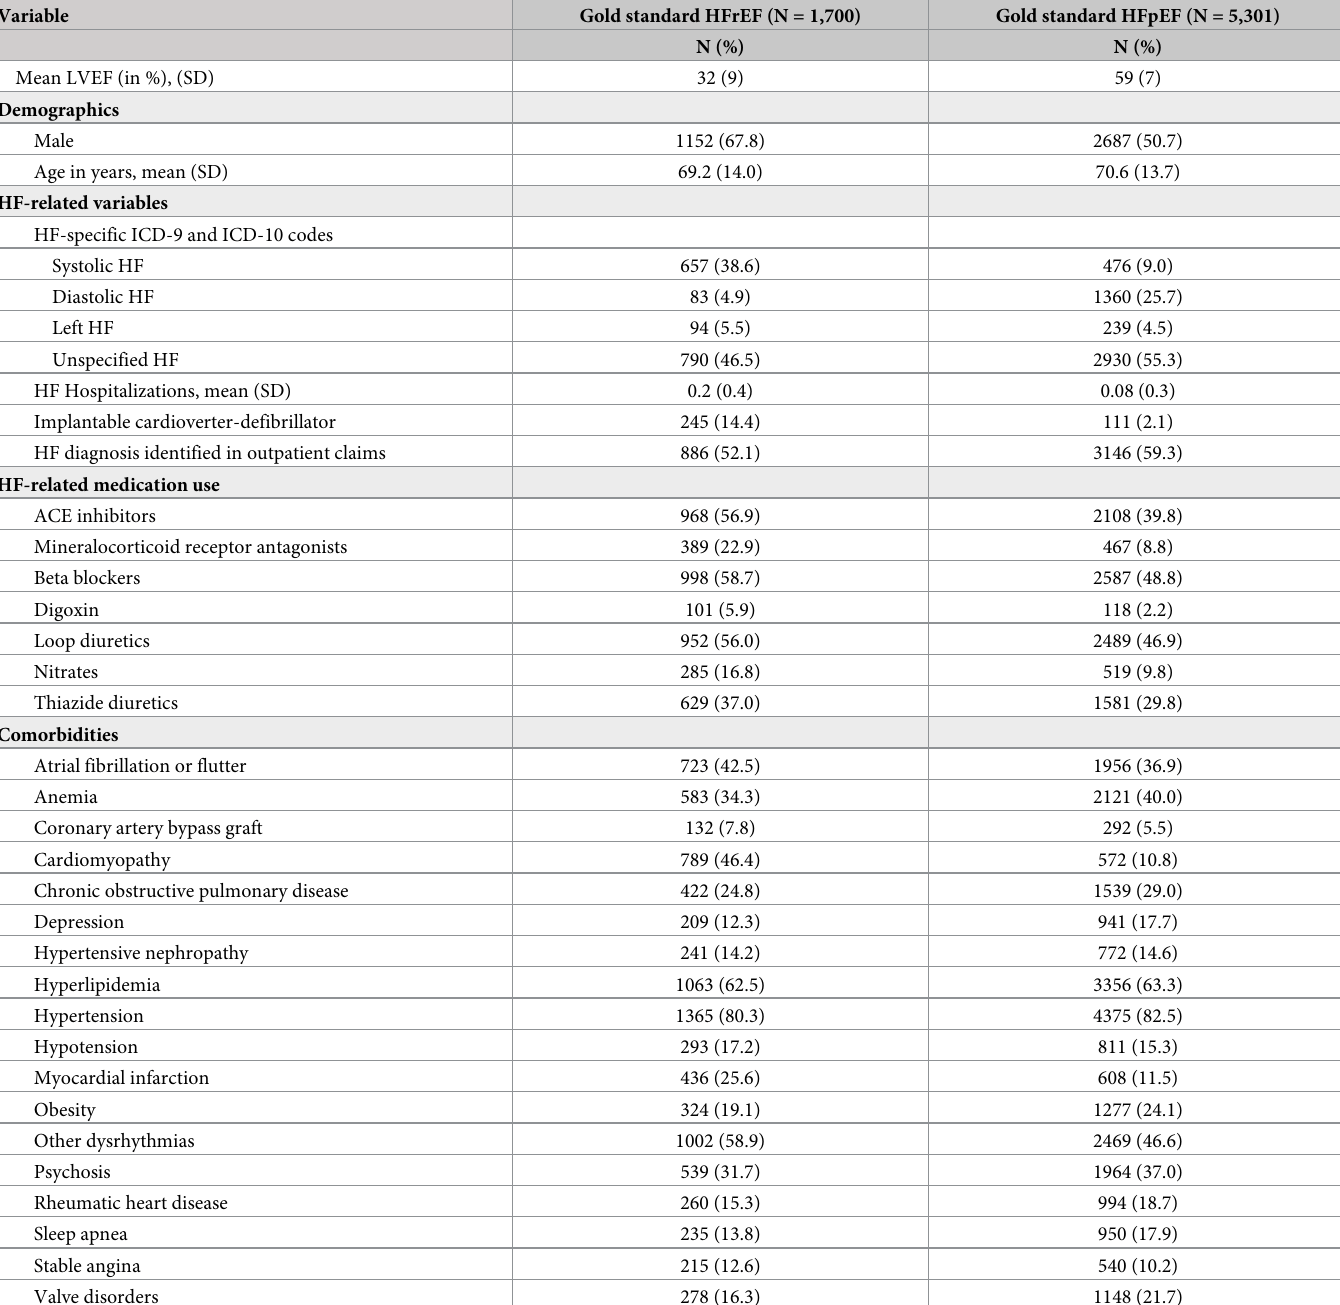
Table 1. Baseline characteristics of HF patients stratified by ejection fraction class (HFrEF, < 0.45; or HFpEF, � 0.45).